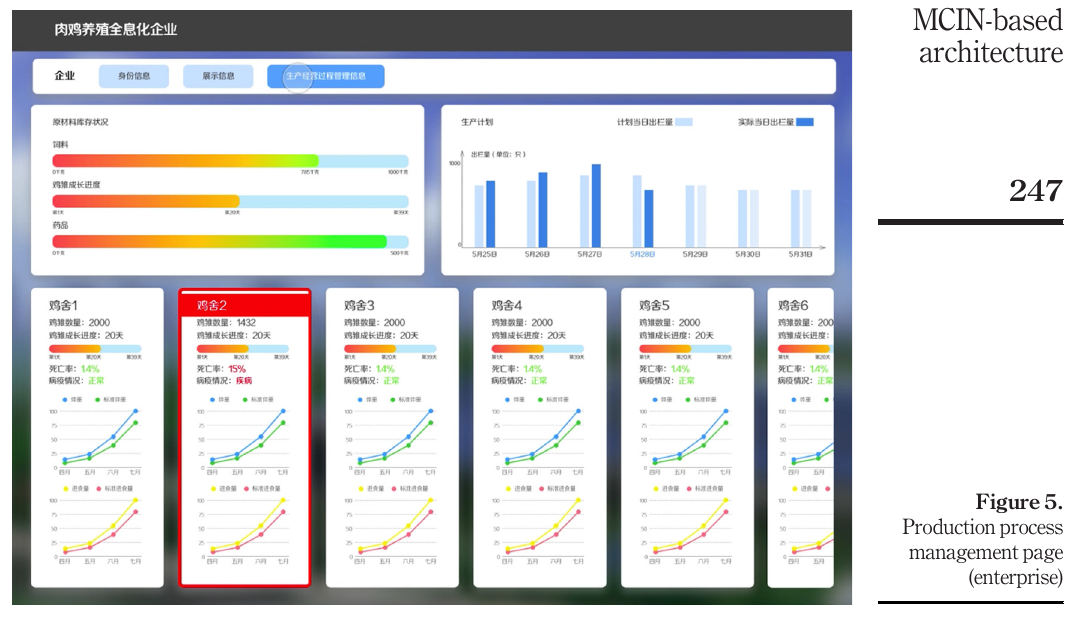
Figure 5. Production process